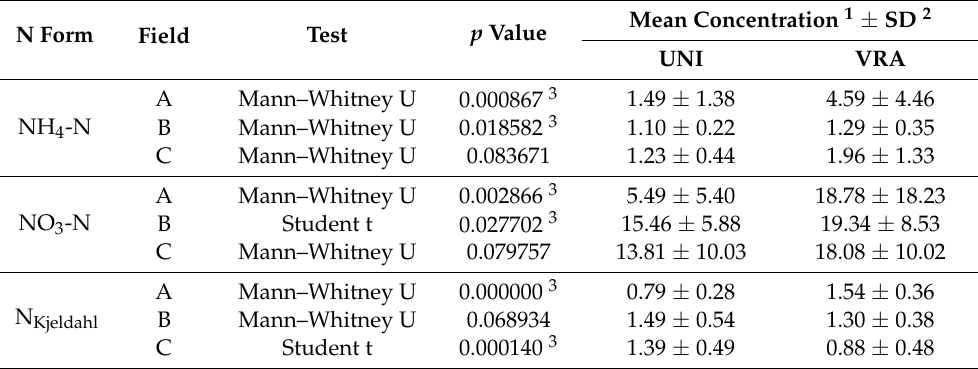
Table 3. Summary of the statistical analysis of differences in the measured content of N forms in soils after uniform (UNI) and spatially variable (VRA)